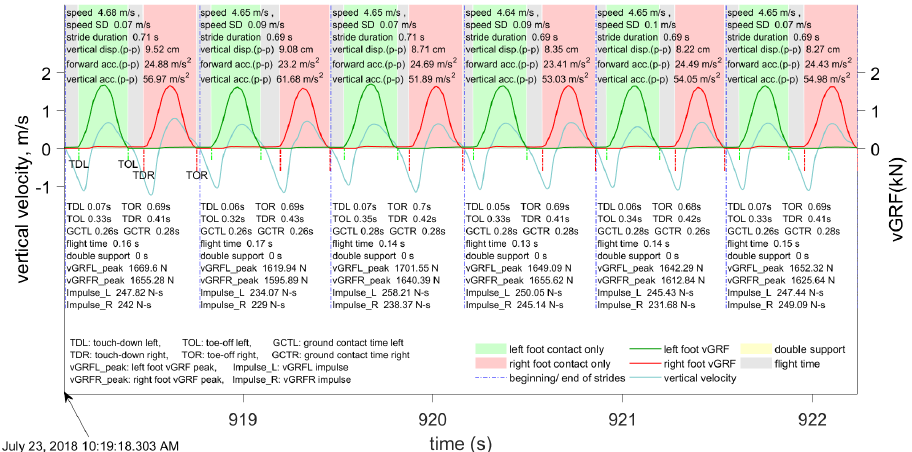
Figure 4. Example of the data computed by the INS/GPS and Moticon insoles during